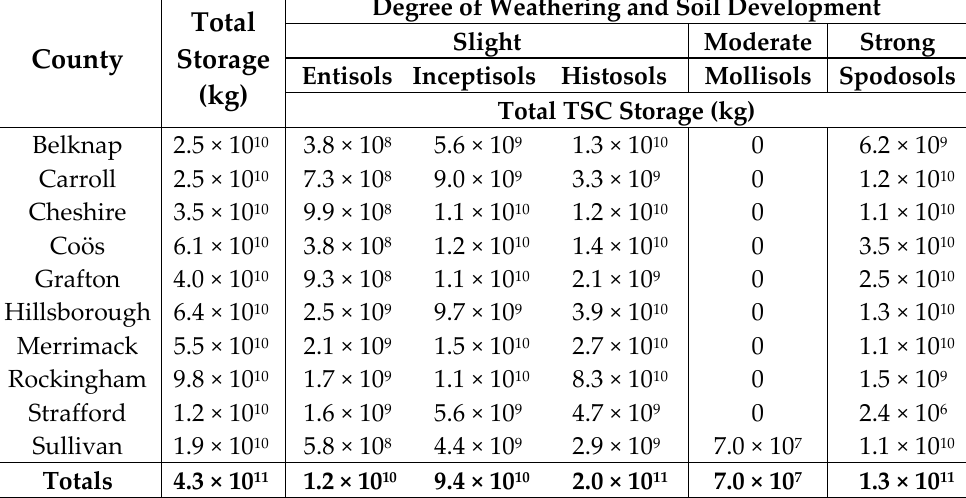
Table 9. Midpoint total soil carbon (TSC) storage by soil order and county for the state of New Hampshire (USA), based on the areas shown in Table 3 and the midpoint TSC contents shown in Table 4.